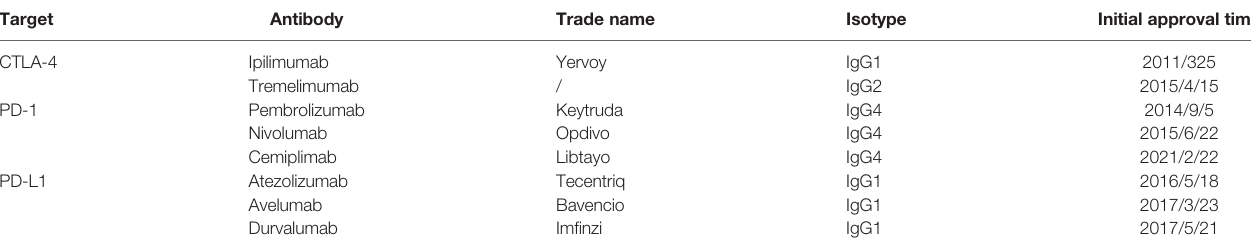
TABLE 1 | Immune checkpoint inhibitor and its application on TNBC treatment: (A) Immune checkpoint